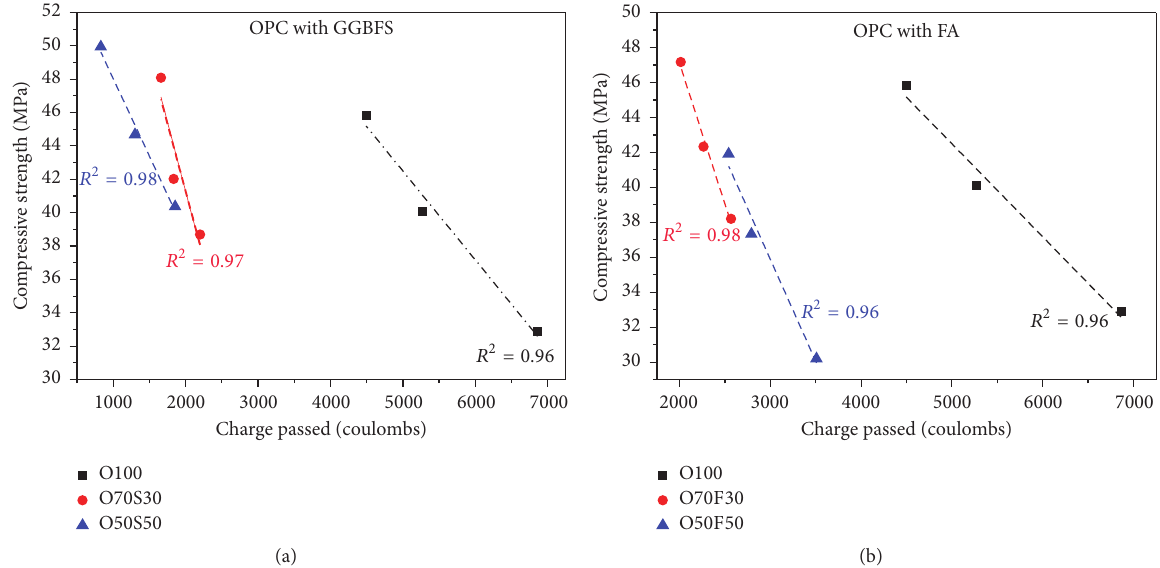
Figure 7: Correlation graph between charge passed coulomb versus compressive strength: (a) GGBFS in HPC and (b) FA in HPC.